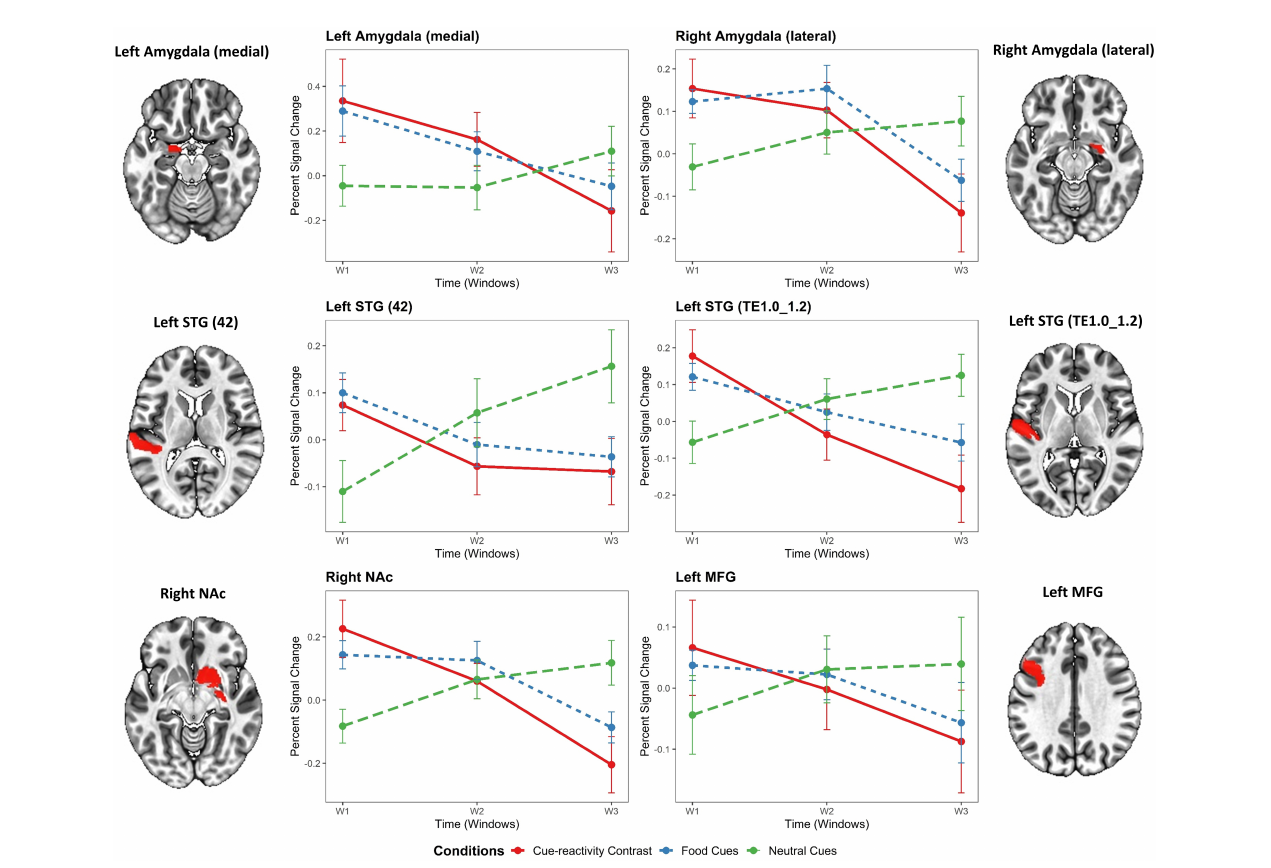
FIGURE4 Temporal dynamics of regions of interest in the food cue-reactivity LME model. General linear model (GLM)-estimated percent signal change in response to food cue reactivity for each region of interest (ROI) with significant time-by-condition interactions in the LME model. Gray and orange labels denote the average main effect of food or neutral cue-exposure condition in the Brainnetome subregions or the result of food vs. neutral contrast. Error bars indicate s.e.m. across overweight and obese subjects ( N = 49) at each temporal window. STG, superior temporal gyrus; NAc, nucleus accumbens; MFG, medial frontal